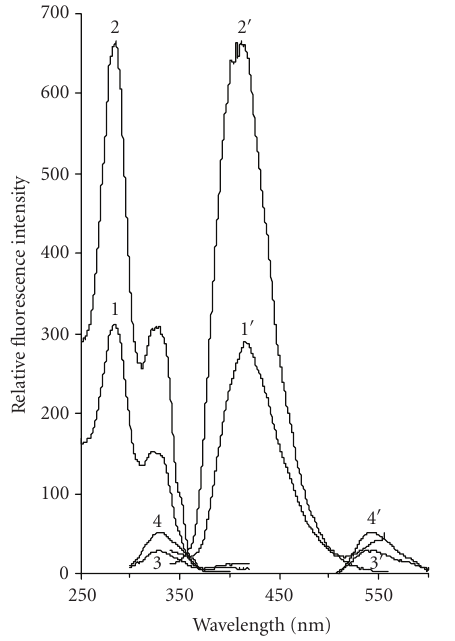
Figure 1: Excitation (1,2) and emission (1 (cid:3) ,2 (cid:3) ) spectra of san- guinarine. (1,1 (cid:3) ) 3 mg/L of sanguinarine in aqueous medium, slits 5nm, λ exc = 283 nm, and λ em = 415nm. (2,2 (cid:3) ) 1 mg/L of san- guinarine in ethanol medium, slits 2.5 nm, λ exc = 283 nm, and λ = 412 nm. In situ excitation (3,4) and emission (3 (cid:3) ,4 (cid:3) ) spectra em of sanguinarine, obtained with the fibre-optic sensor after elution on a silica gel plate. (3,3 (cid:3) ) 20 ng and (4,4 (cid:3) ) 100 ng of sanguinar- ine from ethanol and aqueous solutions, respectively. Slits 10 nm, λ = 326 nm, and λ = 545 nm. exc em